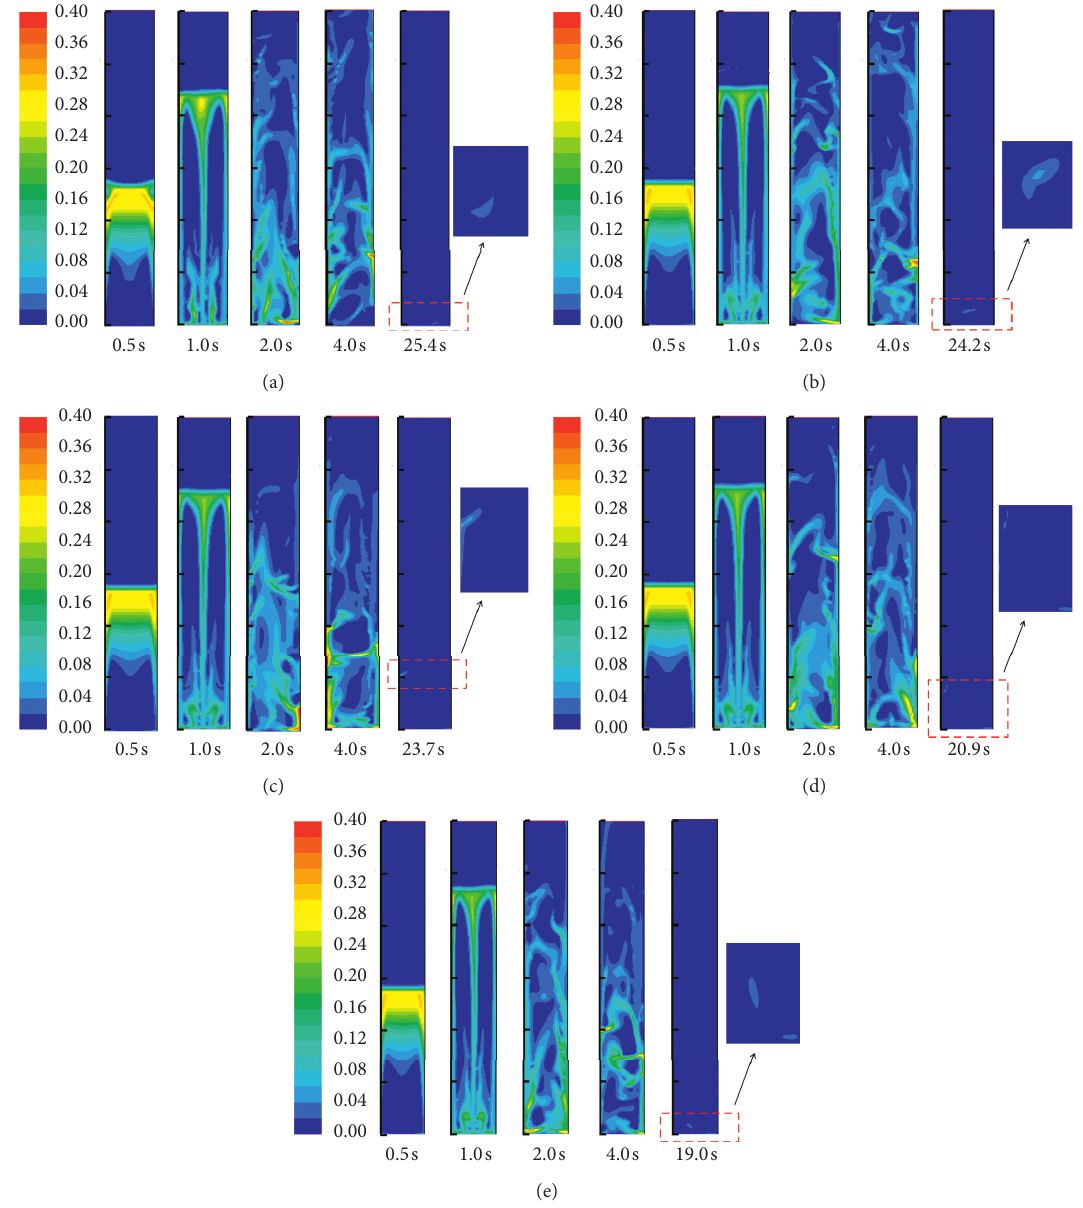
Figure 9: Volume fraction of dust: d � 0.18mm and ρ � 1100kg/m 3 . (a) u � 0.68 m/s. (b) u � 0.69m/s. (c) u � 0.70m/s. (d) u � 0.71m/s. (e) u � 0.72